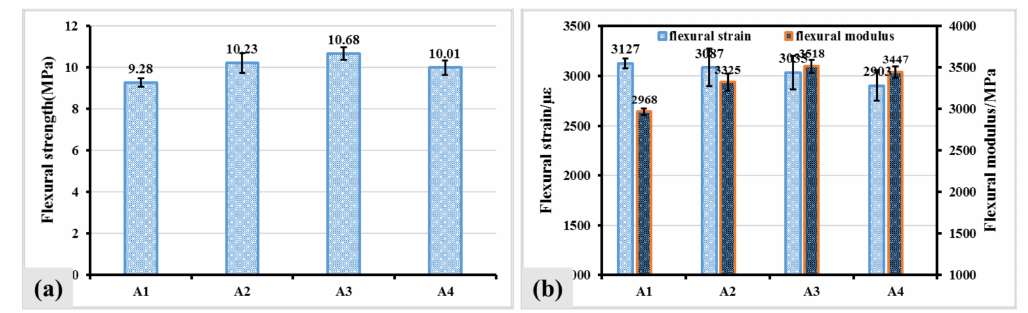
Figure 6. Flexural strength ( a ), Flexural strain and flexural modulus ( b ) of asphalt mixture containing the